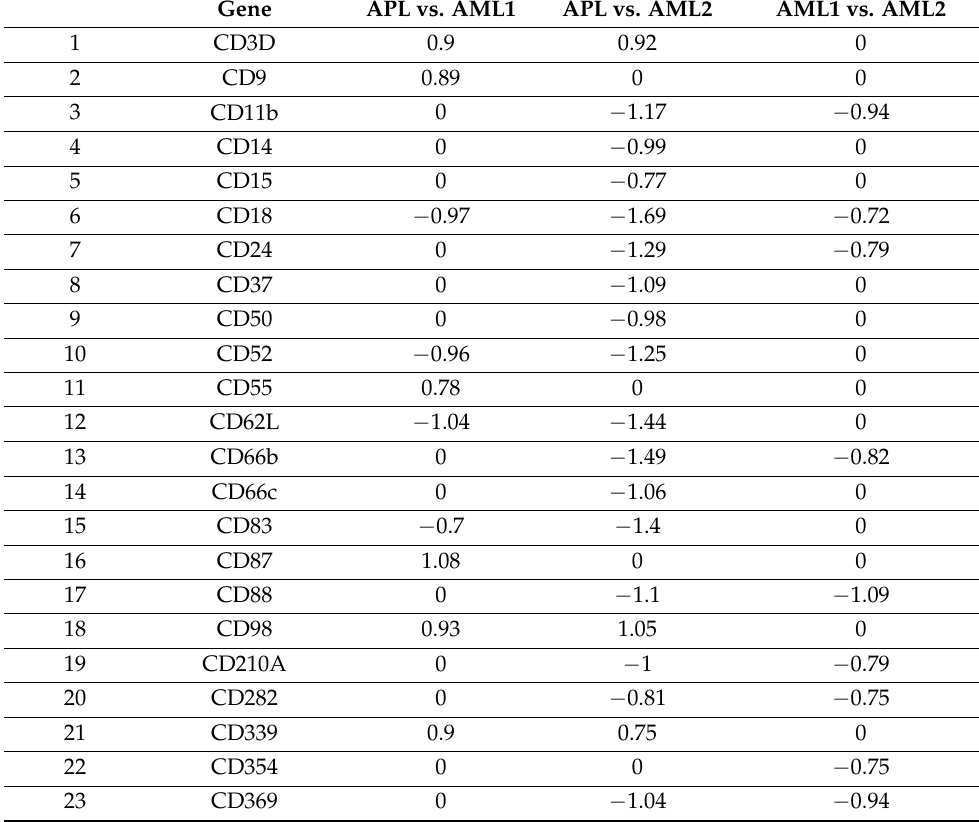
Table 2. The most important differentially expressed CD genes in AML subtypes in the microar- ray dataset. Cohen’s D values are indicated for each dichotomous comparison (group A on the left vs. group B on the right). Positive values indicate higher expression in group A. Negative values indicate higher expression in group B. Values < 0.7 were set to